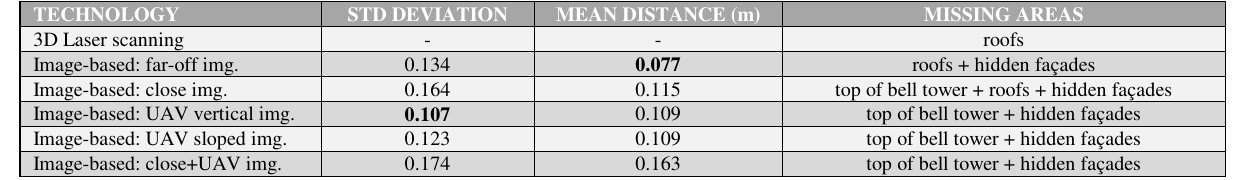
Table 2. Report of main information related to deviations among point clouds built using different approaches.